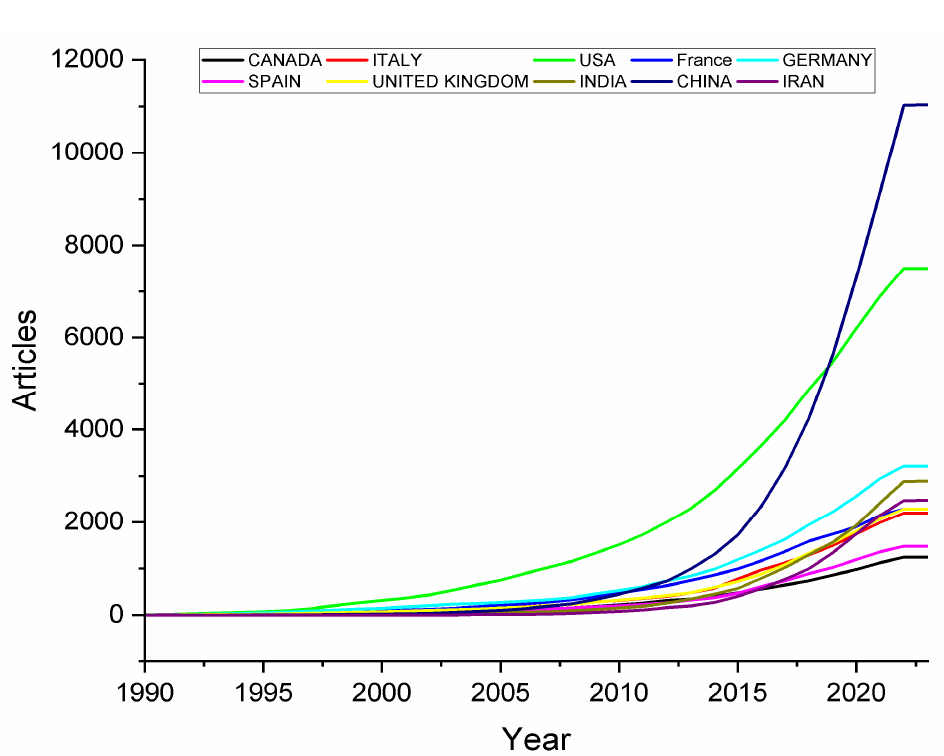
Figure 15. Number of articles over time according to country of origin.